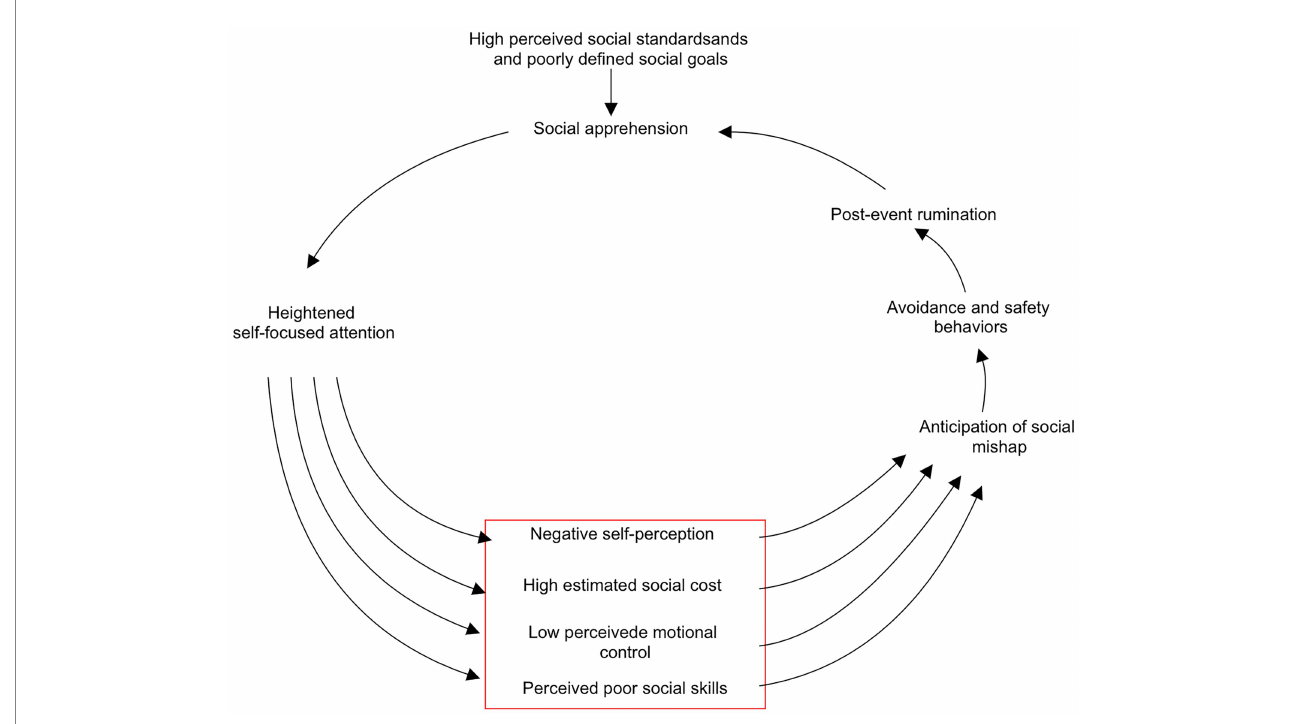
FIGURE 1 Hofmann’s social anxiety disorder model (The red square highlighted the four cognitive factors) (Hofmann,